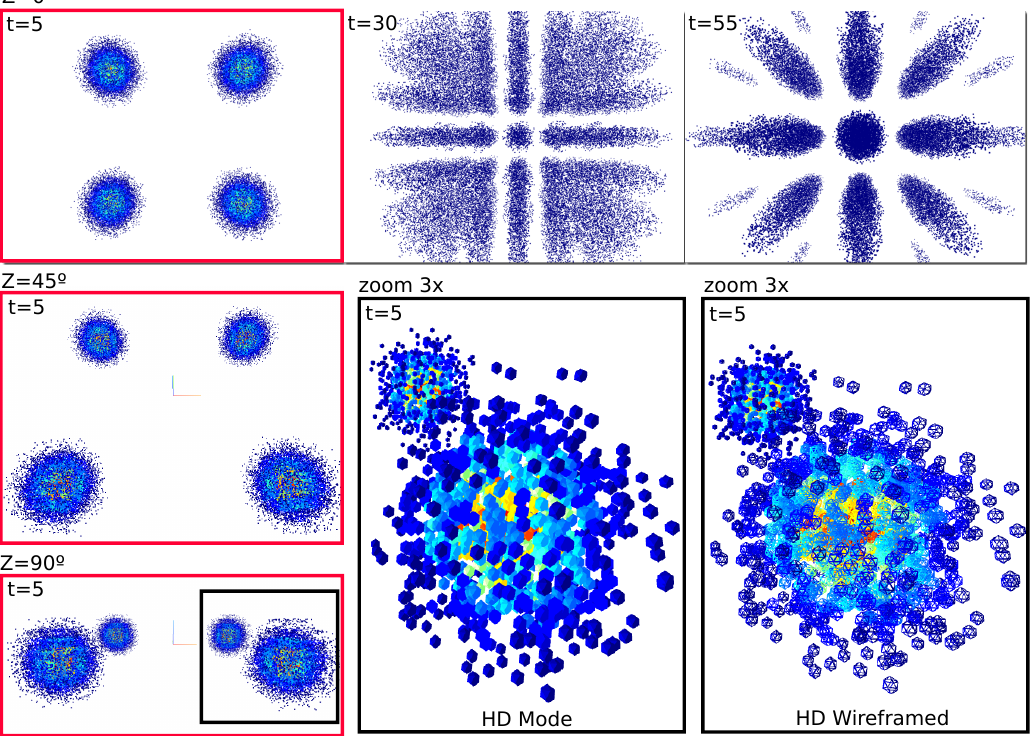
Figure 11. Illustration of the evolution of a wavefunction leading to quantum